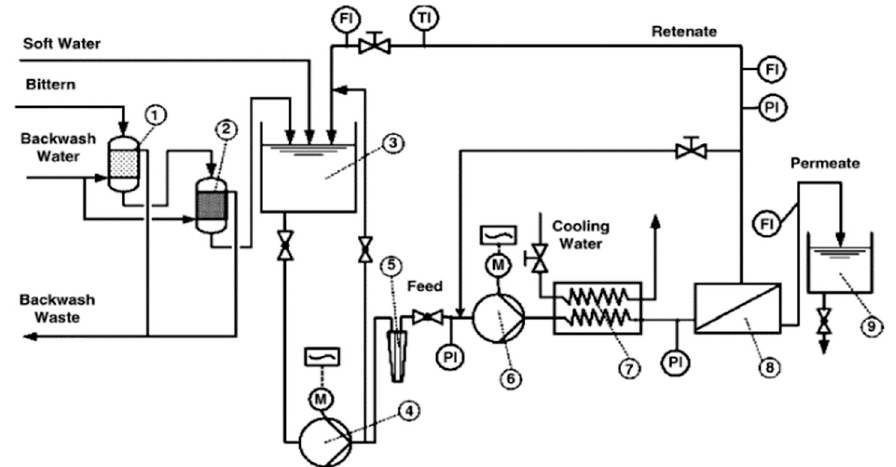
Figure 8. Experimental set-up of the NF treatment; (1) multimedia filter; (2) manganese dioxide sand filter; (3) feed tank; (4) feed pump; (5) polypropylene microfilter; (6) high-pressure pump; (7) heat exchanger; (8) NF membrane element; (9) permeate tank [84].